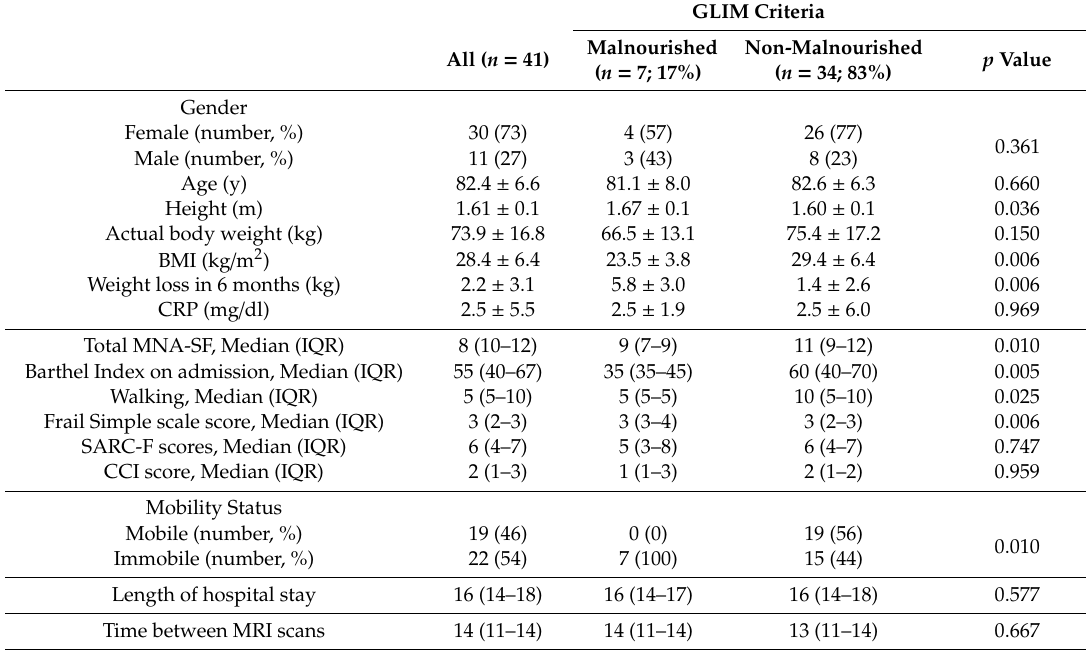
Table 1. Characteristic of study population at baseline (T0) stratified by nutritional status according to GLIM